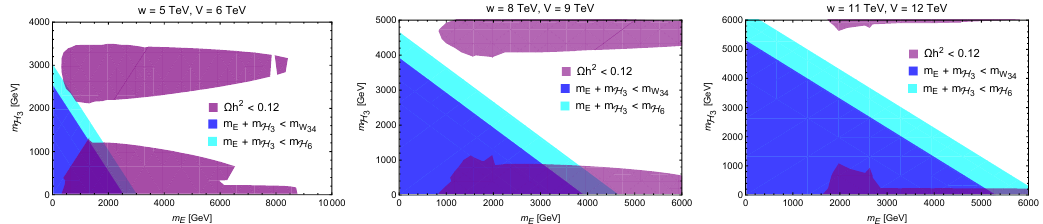
Figure 14 . The total abundance contoured as the function of fermion and scalar dark matter masses, where the dark matter stable regimes are also shown, according to each choice of w; V